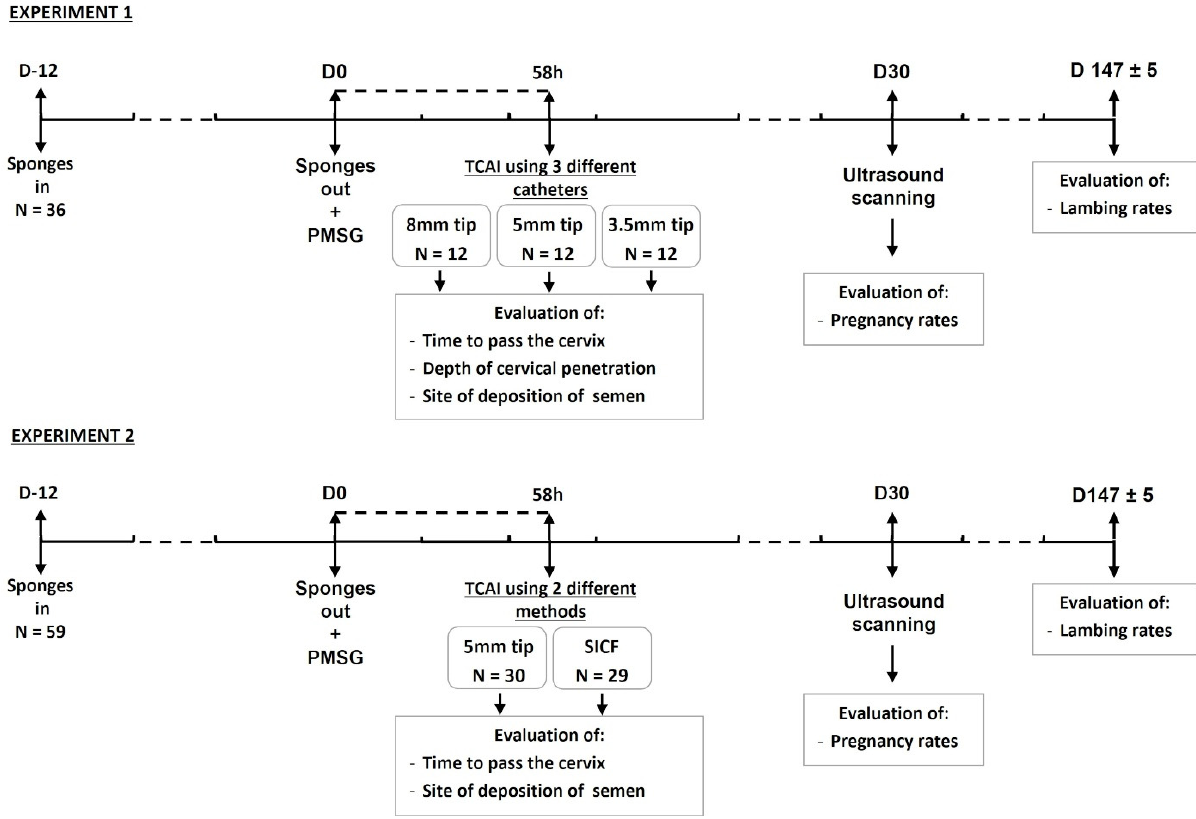
Figure 1. Design of the two experiments. Abbreviations: N = number; D = day; TCAI = transcervical artificial insemination; SICF = surgical incision of cervical folds.